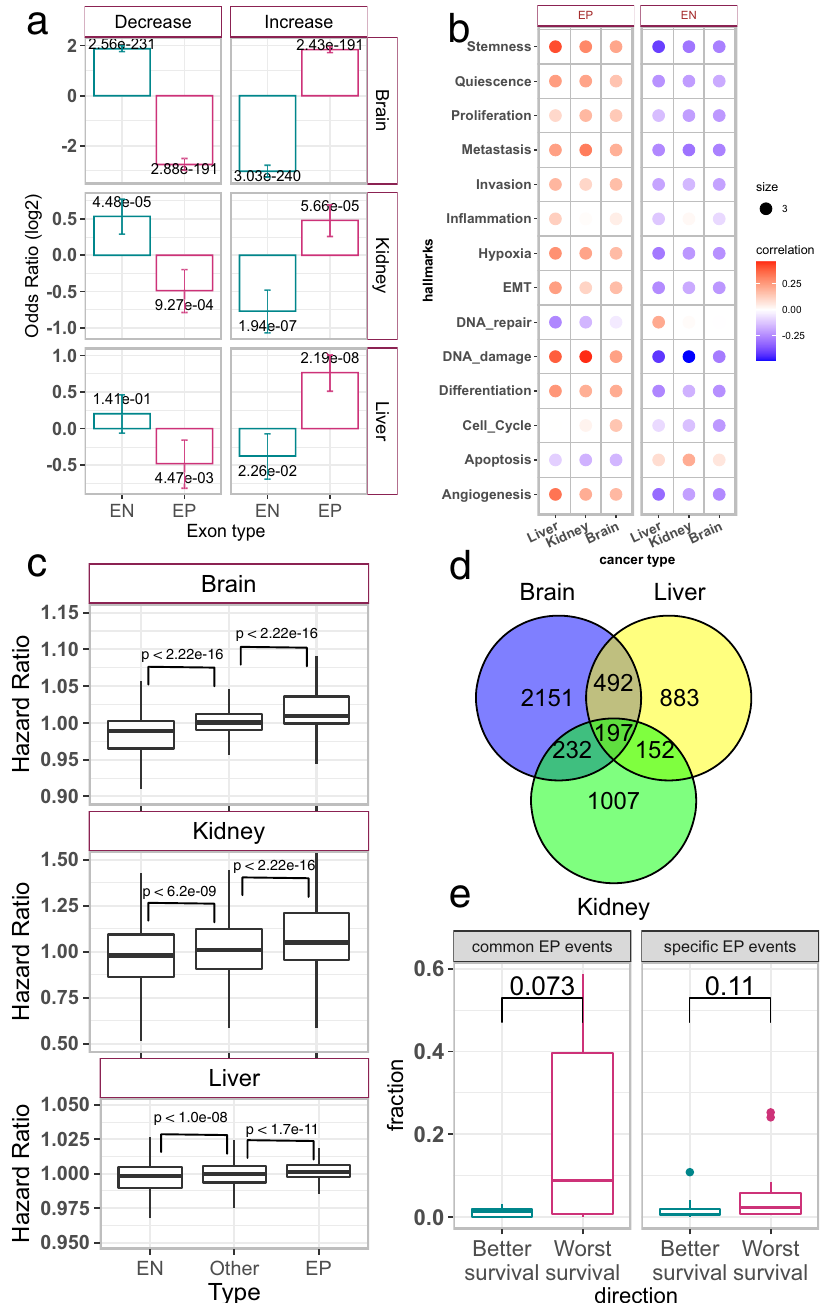
Fig. 2 | Embryonic splicing events in cancer. a Bar plots showing the odds ratio and 95% con fi dence intervals (whiskers) calculated using Fisher ’ s test to assess the statistical signi fi cance of overlap between embryonic splicing events and fre- quently increased/decreased events in cancer for brain, kidney, and liver. The numbersatthe top of each barareFDR-corrected two-sided p -valuesfrom Fisher ’ s test. b Dotplotsfor Pearson ’ s correlation betweenthe medianinclusion levelofEP andENeventsand meanexpression(log(tpm+1))ofthecancerSEAhallmarkgene sets in cancer samples. c Boxplots distribution ofhazard ratios ofthe EP( n =3051) andEN( n =3457)detectedinbrain,kidneyandliverintheircorrespondingcancers. The ‘ Other ’ set ( n =29,349) of exons are the remining exon and serve as genome- widecontrol.ThecancertypesusedinthisanalysisareLGGforbrain,LIHCforliver, and KIRP for kidney. Two-sided p -values from Wilcoxon ’ s test are shown. d Venn